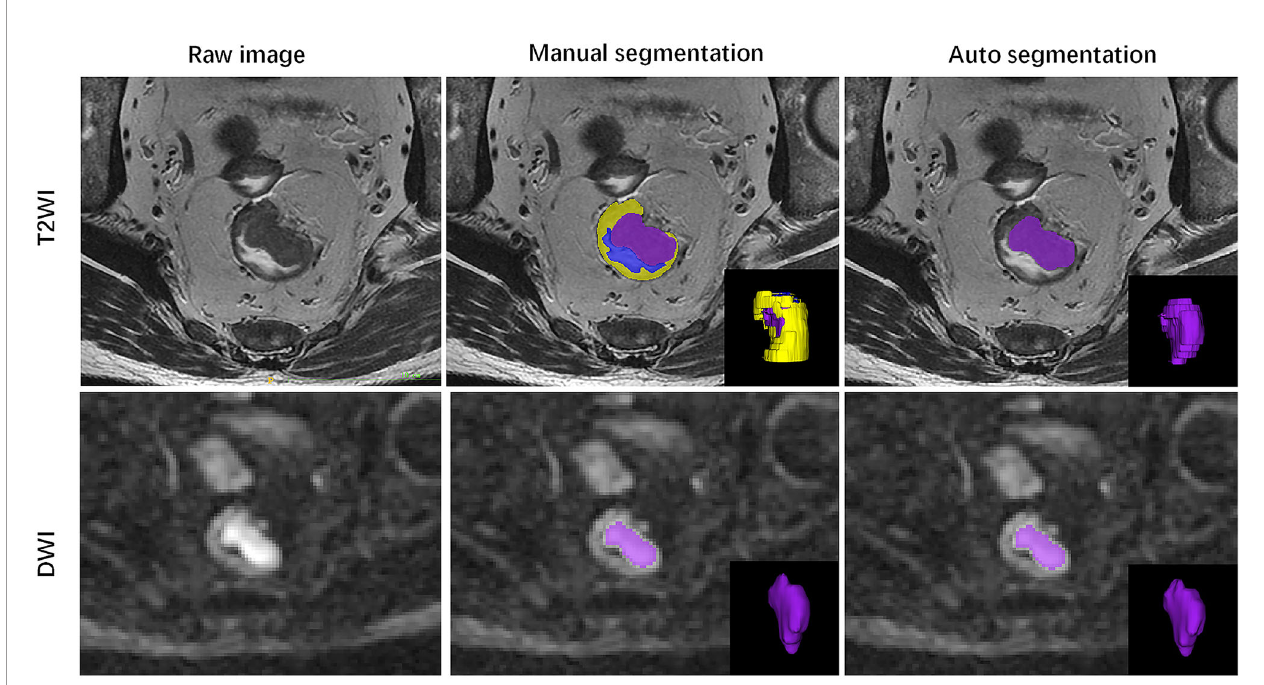
FIGURE 3 | Illustration of automated segmentation using 3D V-Net versus ground truth on rectal MR images of a 51-year-old male. Purple indicates tumor, yellow indicates normal rectal wall, and blue indicates lumen. The Dice was 0.980 on T2WI and 0.981 on DWI for this